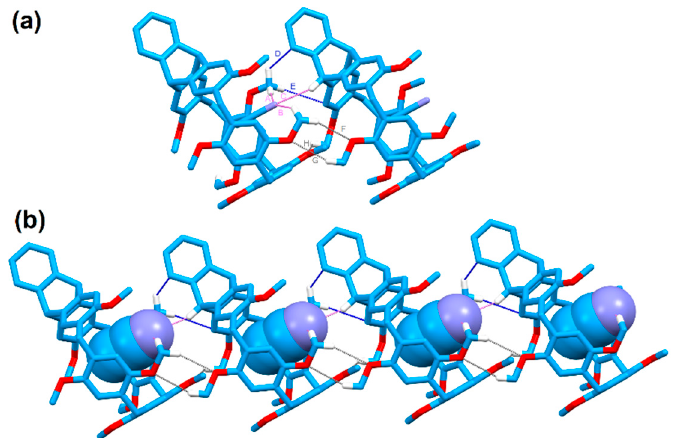
Figure 4. ( a ) Crystal structure and ( b ) packing mode along the c axis of P - H . Dotted lines denoted the noncovalent interactions between P - H and CH 3 CN (violet for C − H···N interactions, grey for C − H···O interactions and blue for C − H··· π interactions). Hydrogen atoms not involved in the non- C − H ··· O interactions and blue for C − H ··· π interactions). Hydrogen atoms not involved in the covalent interactions were omitted for clarity. noncovalent interactions were omitted for